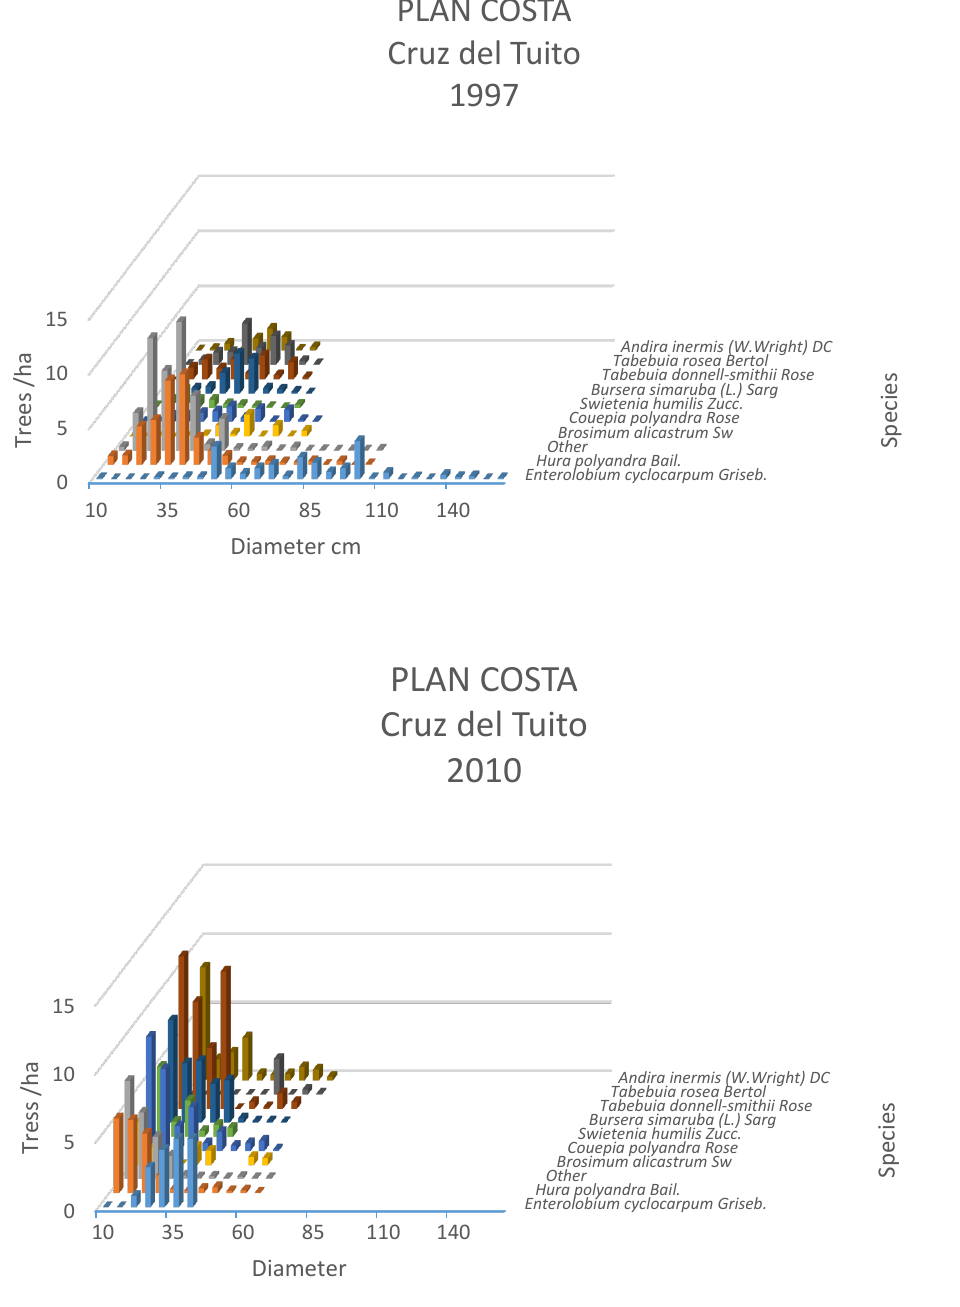
Figure 2. Diameter frequencies 1997–2010 of important timber species managed by PLAN COSTA in Comunidad Indígena Santa Cruz del Tuito, Jalisco,